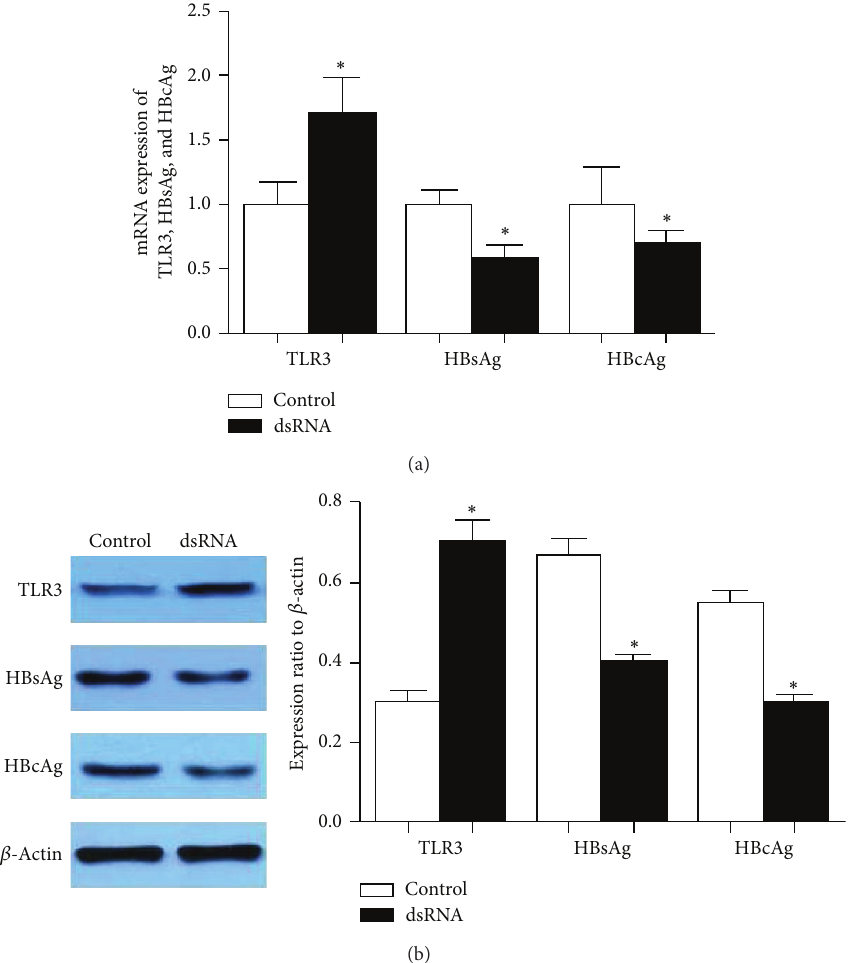
Figure 5: dsRNA stimulated the expression of TLR3 and inhibited the expression of HBsAg and HBcAg in HepG2.2.15 cells. (a) By qRT-PCR. (b) By western blotting ( ∗ 𝑃 < 0.05 versus control group).